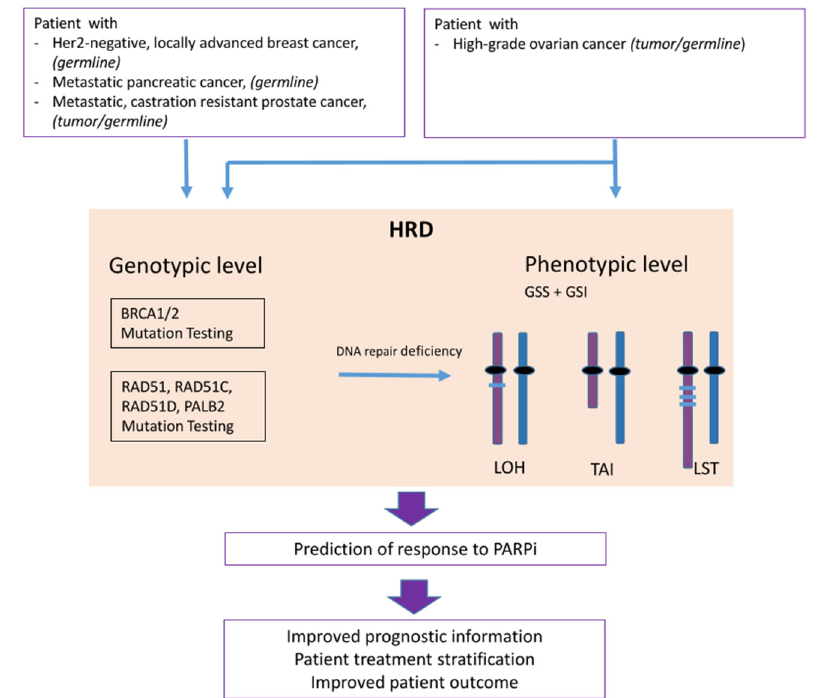
Figure 3. Flow chart and concept of homologous recombination deficiency (HRD) testing; from patient sample over genotyping and phenotyping to prediction of response to PARP inhibition (PARPi). Loss of heterozygosity (LOH), telomeric allelic imbalance (TAI) and large scale state transitions (LST), genomic instability score (GSI), genomic scare score (GSS).